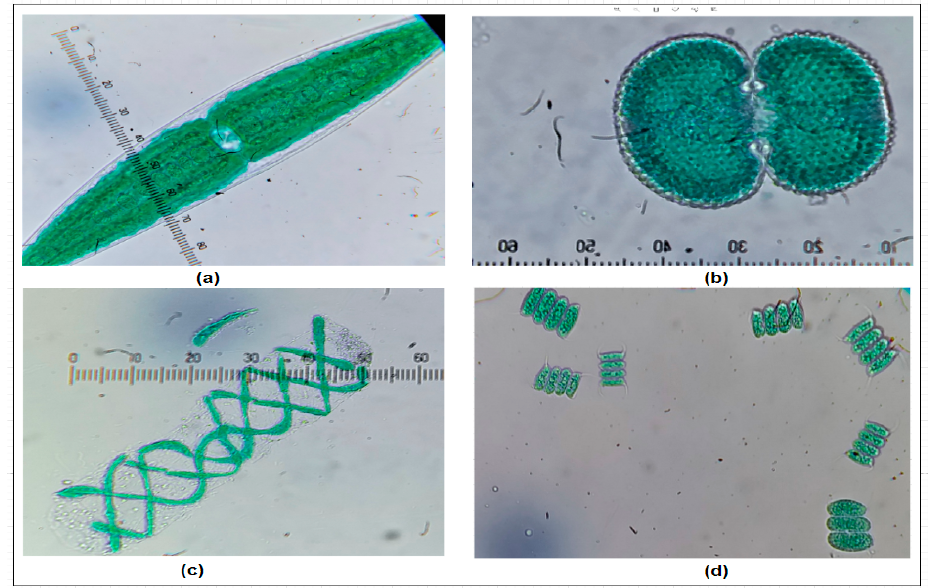
Figure 1. Samples of all the four algae classes. ( a ) Closterium, ( b ) Cosmarium, ( c ) Scenedesmus, ( d ) Spirogyra .